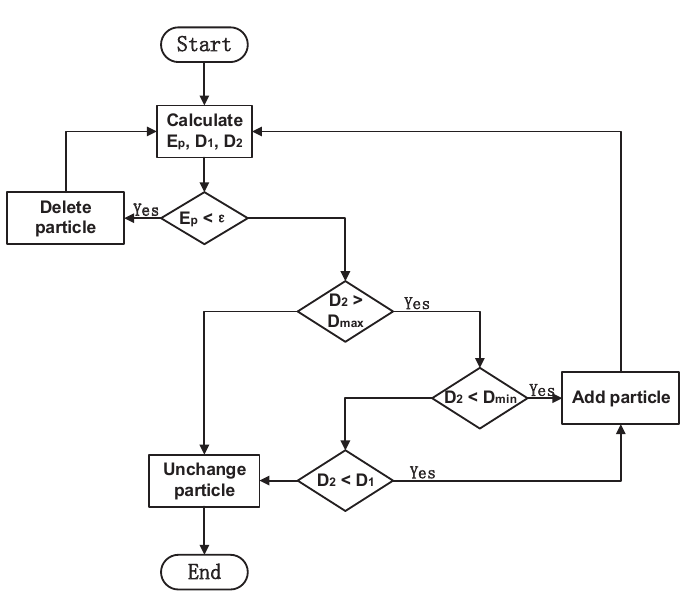
Figure 5. Adaptive PSO algorithm